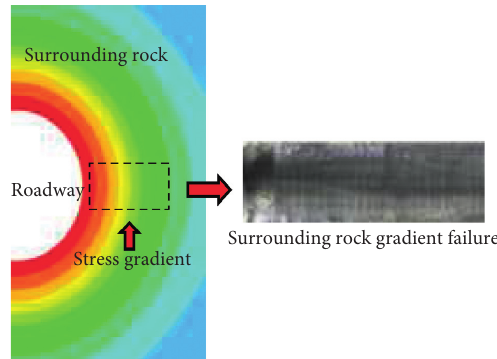
Figure 6: Schematic diagram of the surrounding rock failure of the